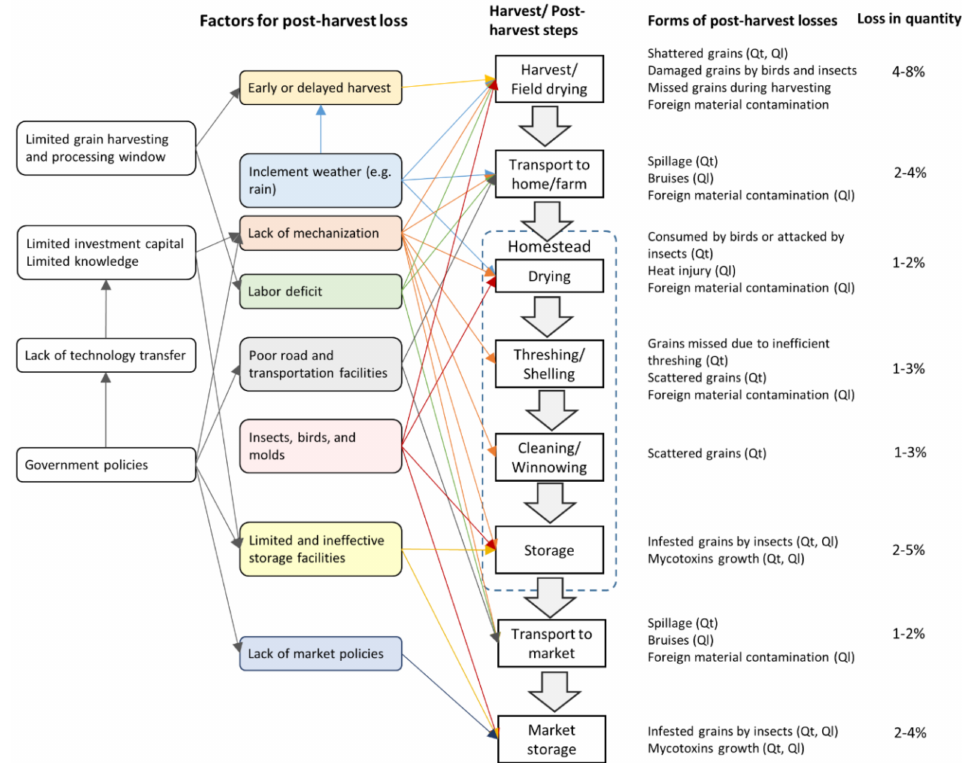
Figure 1. Factors for losses during different post-harvest steps of the grain supply chain in developing countries [7–9]. Note: quantitative grain losses for harvest and different post-harvest steps provided in this figure are based on information provided in African post-harvest information system (APHLIS) [9]. However, grain storage losses up to 34% have been reported by different studies [4,10–12]. Qt—Quantitative loss, Ql—Qualitative